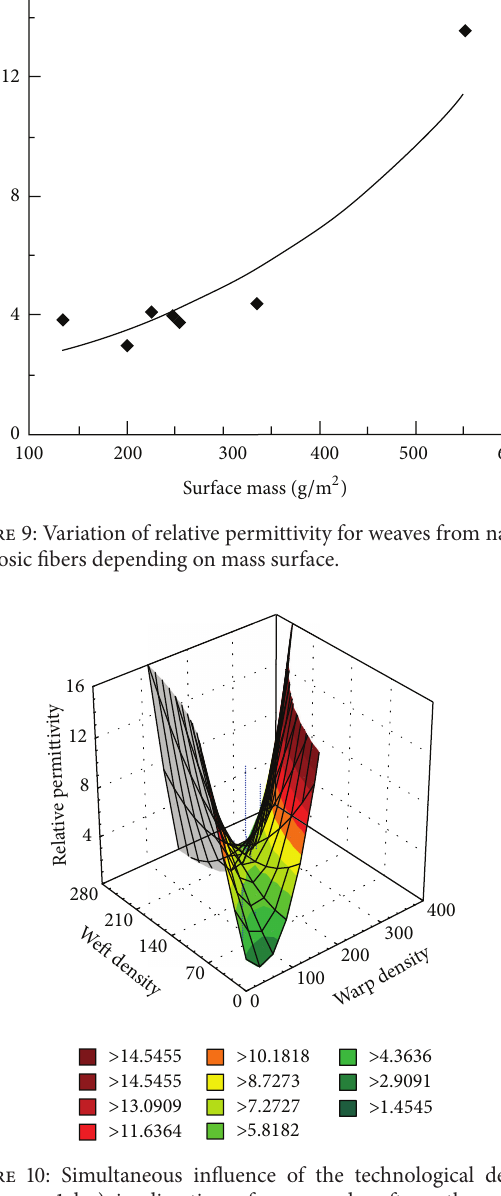
of the electrical permittivity of the pure jute weave packing is comparable to that of the permittivity for the glass thread at 25 ∘ C and 35% air humidity.